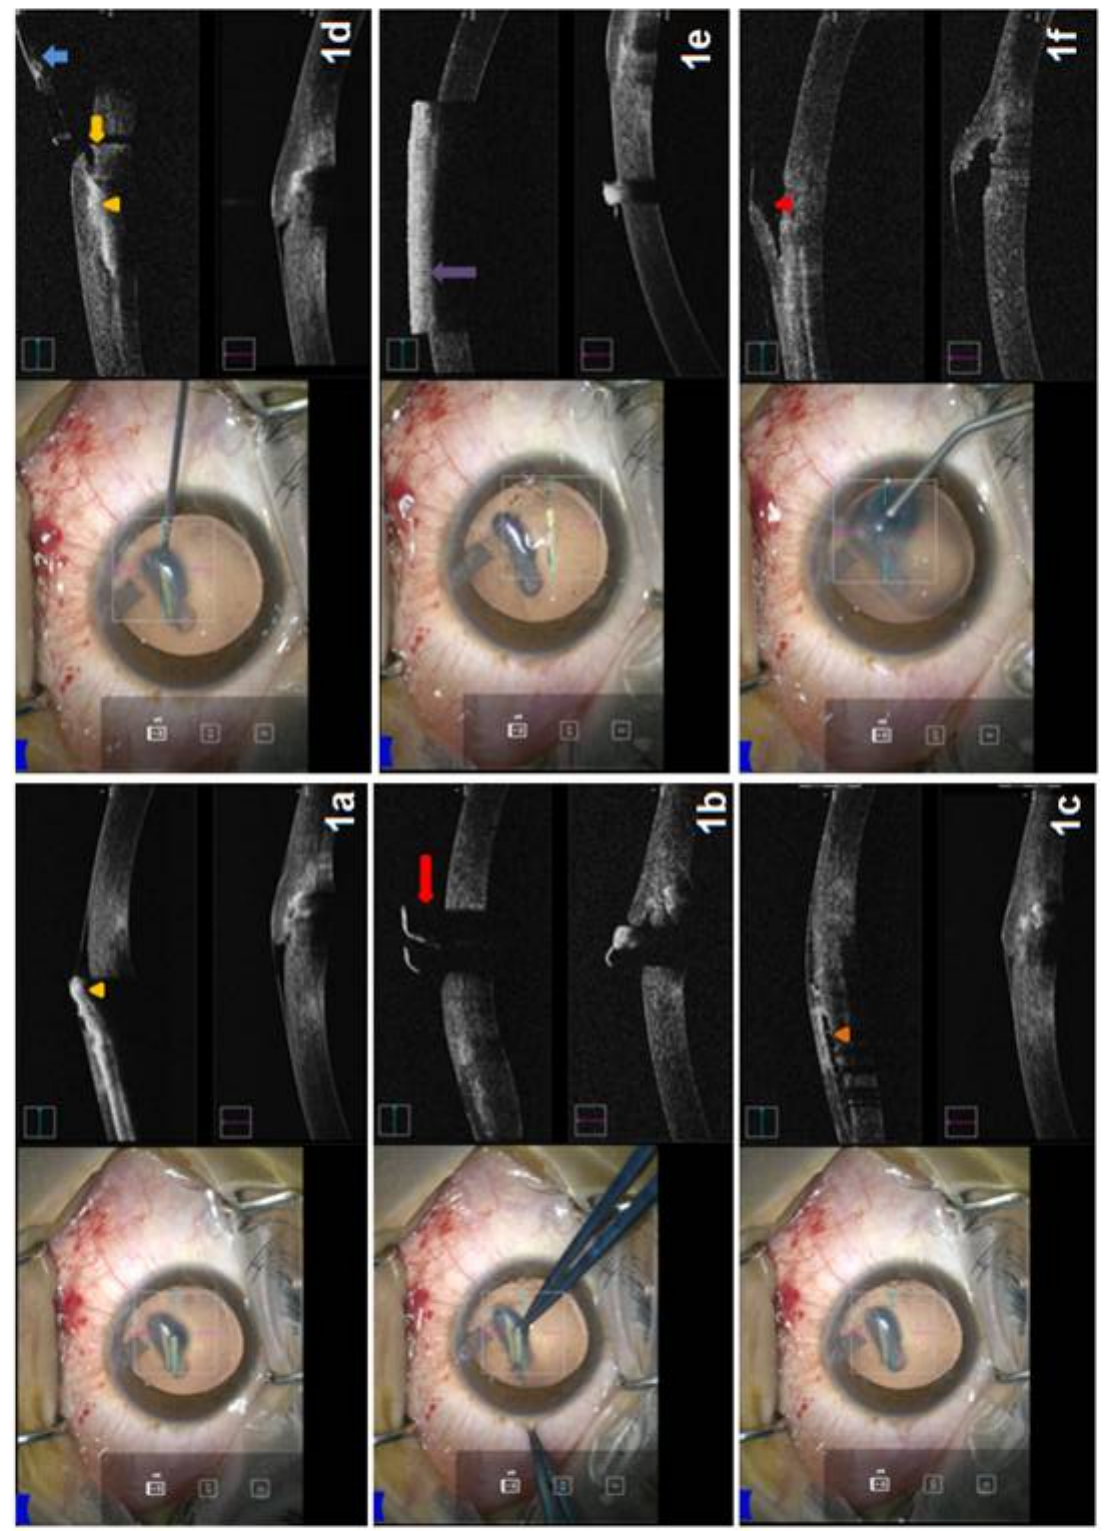
Figure 1: 1a shows a hyperreflective structure (yellow arrow head) embedded in the anterior cornea, suggestive of an intracorneal sugarcane particle. The proximal end of the particle can be seen piercing through the corneal epithelium and anterior stroma causing a lamellar laceration. 1b shows that the sugarcane particle was held using Lim’s forceps (red arrow) while looking at the real-time images provided by Mi-OCT. 1c shows the tract of the sugarcane particle which appeared as a hyporeflective space (orange arrowhead) in the anterior cornea. 1d shows the second sugarcane particle which appeared as a hyperreflective structure (yellow arrowhead), with a narrow tract (yellow arrow). ILM forceps (blue arrow) was guided using the real-time images to retrieve it atraumatically. 1e shows the sugarcane particle lying on the corneal surface after removal. It appeared hyperreflective with back shadowing. 1f shows lamellar tissue defect (red arrowhead) once both foreign bodies were removed.